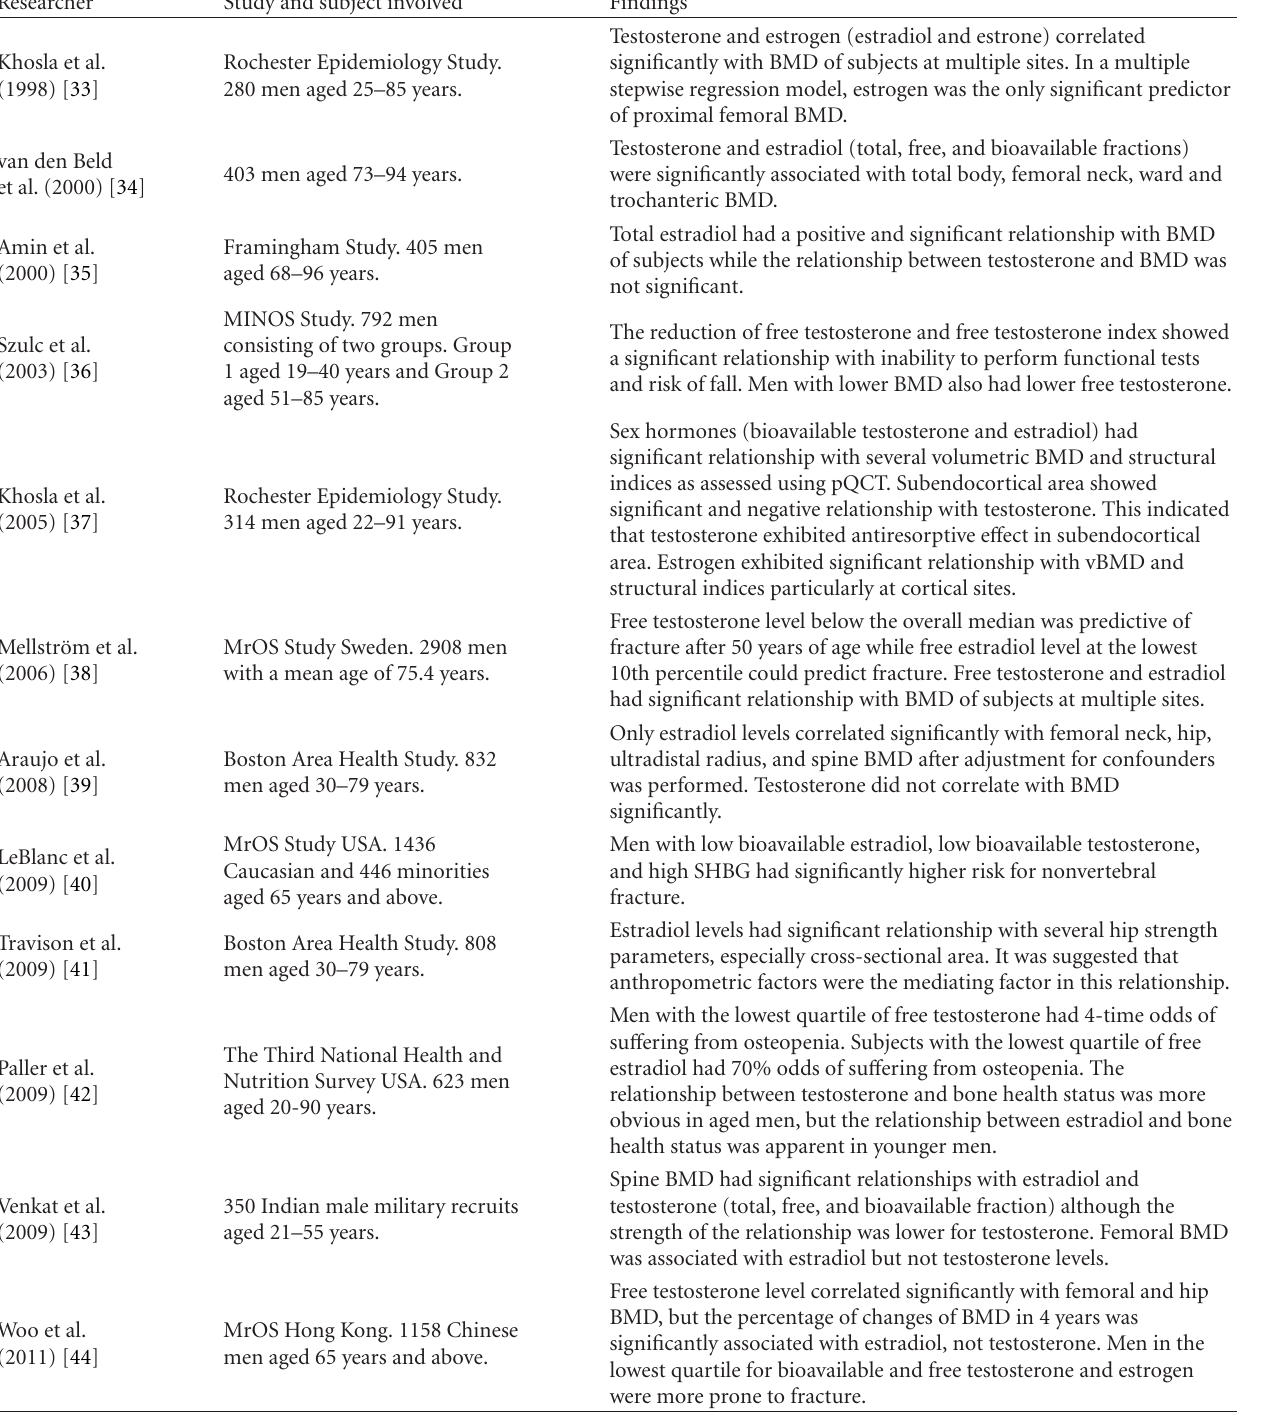
Table 1: Epidemiological studies on the relationship between sex hormones and bone health status in